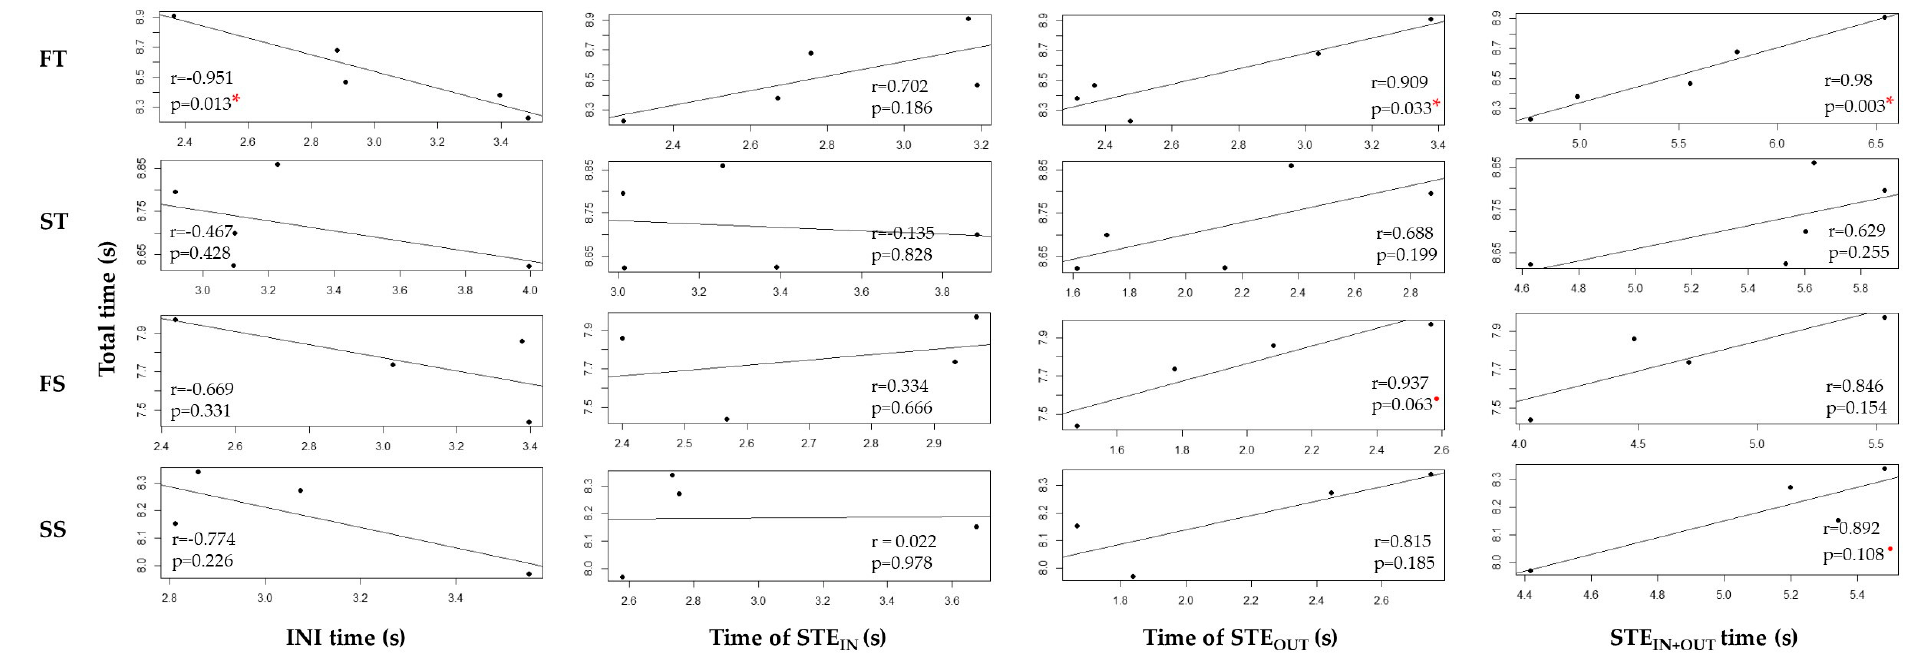
Figure 4. Correlations between the total descent time and the partial times (INI time, initiation time; time of STE IN , time of steering into the turn; time of STE OUT , time of steering out of the turn; STE IN+OUT time, steering time) for four SL-courses (FT, flat turned course; ST, steep turned course; FS, flat straighter course; SS, steep straighter course). r, coefficient of correlation; p , level of significance at 5% or 10%, indicated with a red asterisk or a dot, respectively.